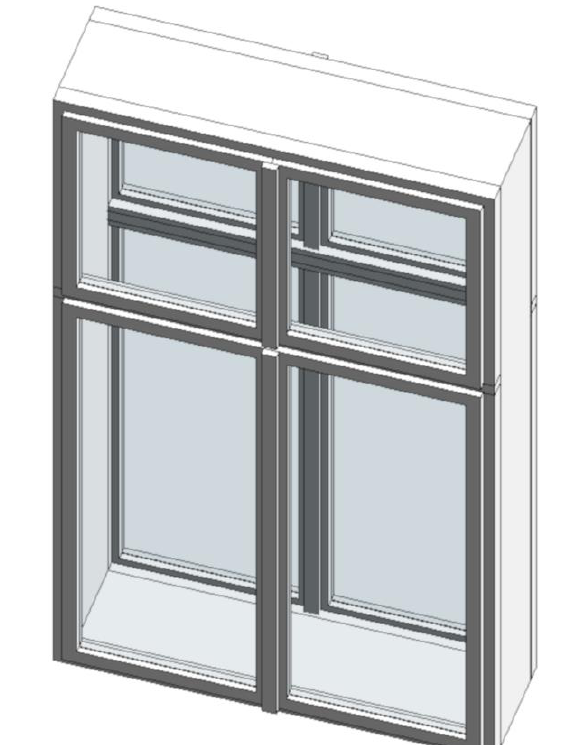
Figure 8. Example of the HBIM component – double lining window